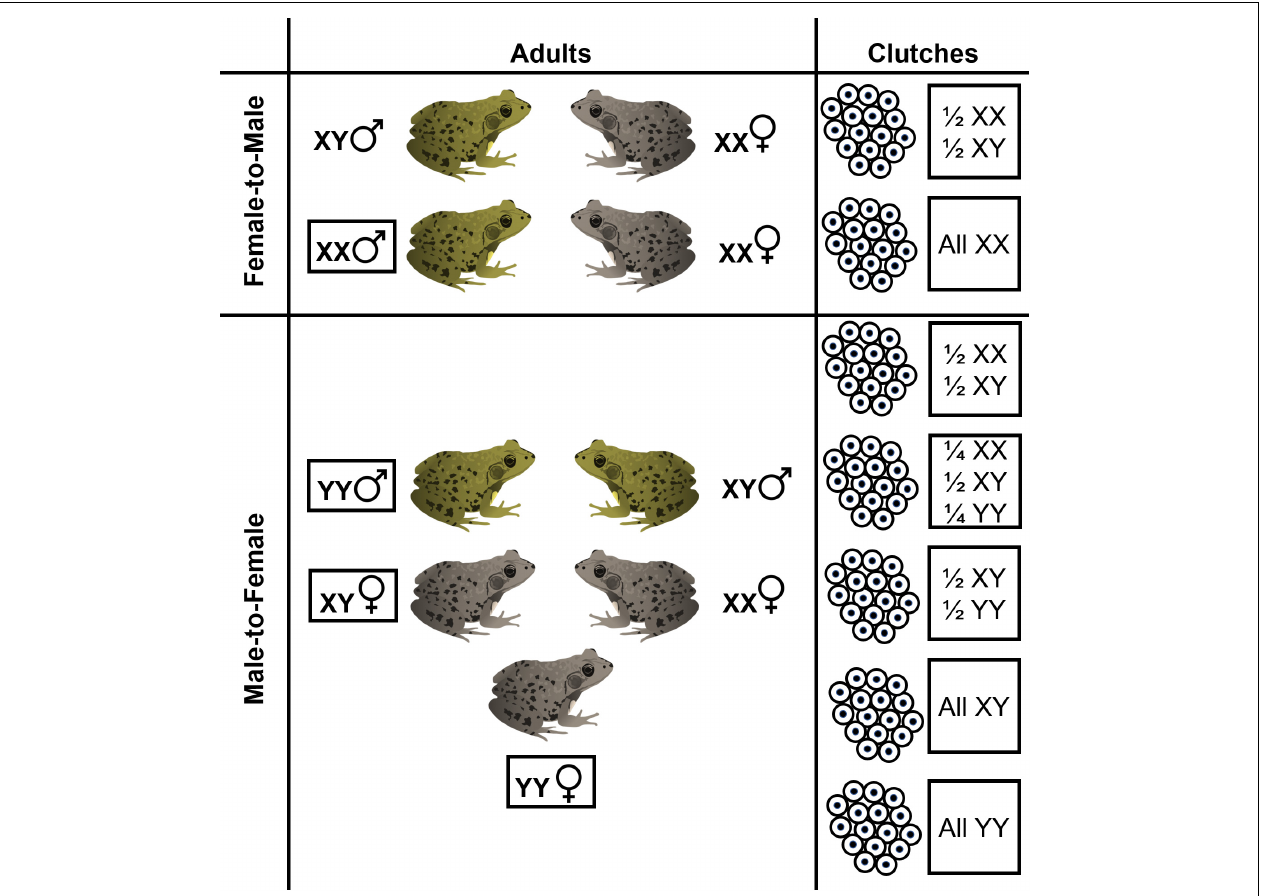
FIGURE 7 | Breeding by sex-reversed adults, either due to female-to-male or male-to-female sex reversal, can result in a diversity of hypothetical clutch genotypic sex ratios. In species such as R. clamitans which have an XX-XY male heterogametic sex chromosome systems, if YY individuals are viable, sex reversal may produce phenotypic females that have two Y-chromosomes. Shown are the various hypothetical genotypic-phenotypic sex combinations for adult frogs and associated clutch genotypic sex ratios that can result from various crossings. Other genotypic sex ratios may occur for clutches if mutliple paternity or clutch piracy occurs.